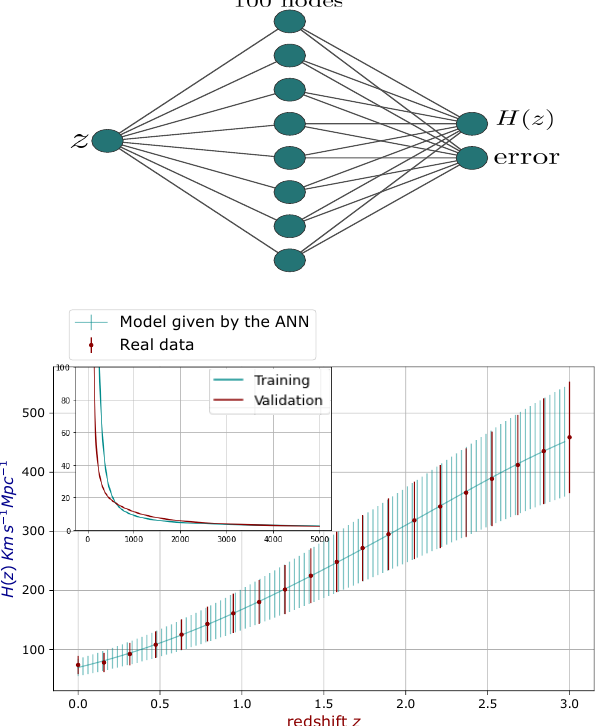
Figure 4. ( Top ): Neural network architecture. The input layer receives the redshift and the output layer generates a value for the Hubble parameter and its respective error. ( Bottom ): Predictions of an ANN model for the Friedmann equation from a few data points. Red error bars are the original data used to train the architecture. Turquoise bars represent the predictions of the trained ANN. In the top left corner is the behaviour of the loss function on both the training and validation